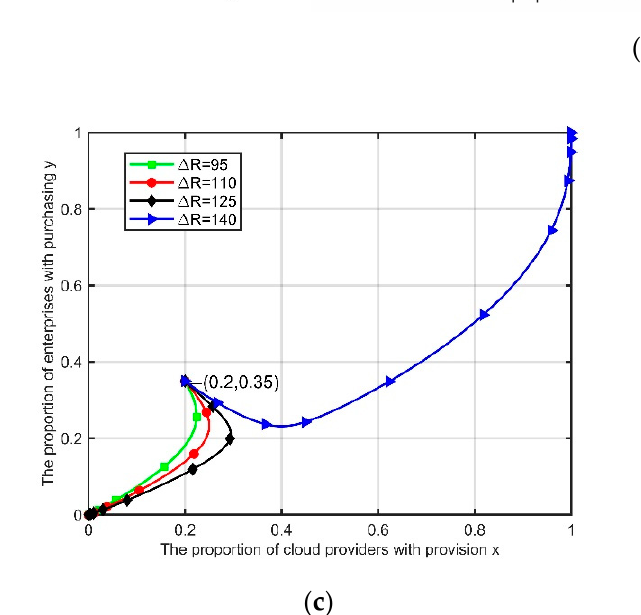
Δ Figure 6. The impact of 2 E and R on Ⅱ S and evolutionary paths (a) The impact of 2 E and Figure 6. The impact of E 2 and ∆ R on S II and evolutionary paths ( a ) The impact of E 2 and ∆ R on S II ; ( b ) The evolutionary paths with different direct benefits E 2 ; ( c ) The evolutionary paths with different S ; (b) The evolutionary paths with different direct benefits R Δ on Ⅱ direct benefits ∆ R Δ . paths with different direct benefits R